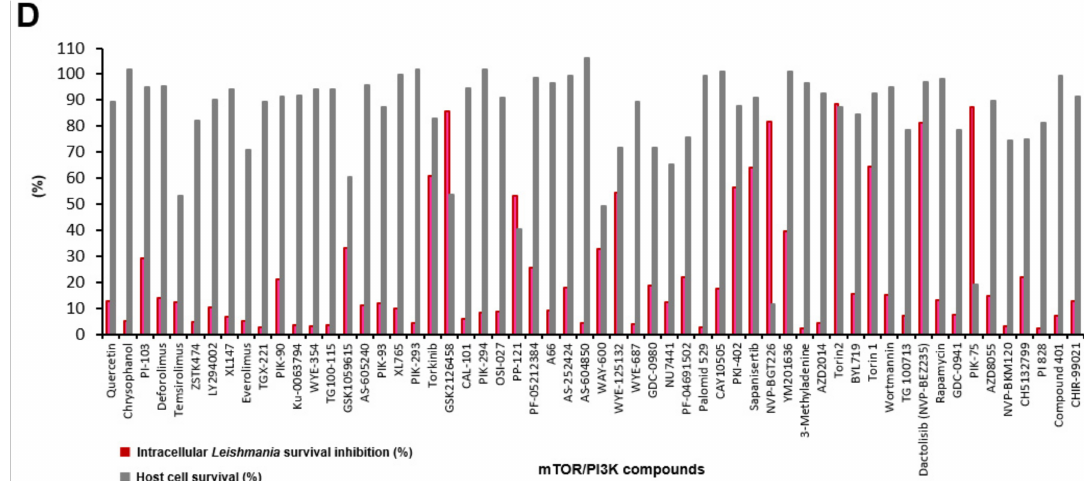
Figure 1. Pilot screening results for intracellular L. donovani infection in THP-1 cell line. Red, negative control (DMSO); black, positive control (4 µ M amphotericin B); gray, compound. A total of 1742 compounds were screened, with R 2 = 0.922 ( A ) , Z (cid:48) = 0.798 ( B ), and host cell survival and intracellular parasite survival inhibition > 60%, black squares ( C ), and cell ratio and intracellular parasite survival inhibition of 58 mammalian target of rapamycin (mTOR) / phosphoinositide 3-kinase (PI3K) compounds ( D